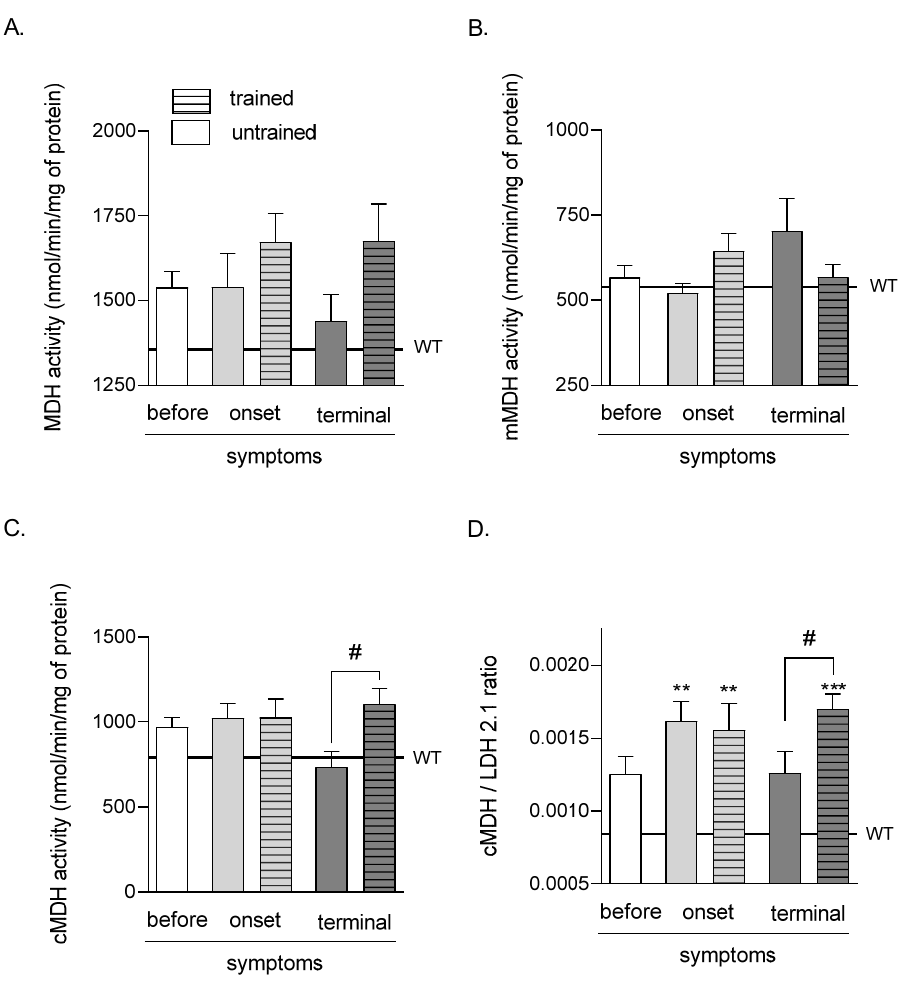
Figure 3. Effects of ALS disease progression and swim training on skeletal muscle MDH, mMDH, cMDH activities, and the cMDH/LDH2.1 ratio. MDH activity ( A ), mMDH activity ( B ), cMDH activity ( C ), and the cMDH/LDH2.1 ratio ( D ) were measured in the tibialis anterior muscle of mice. There were significant differences between the groups: ** p < 0.01 and *** p < 0.001 vs. WT group of mice (Tukey’s post hoc test), # p < 0.05 between indicated group (Student’s t -test). The data are presented as the means ± SEM ( n = 7 in each group).